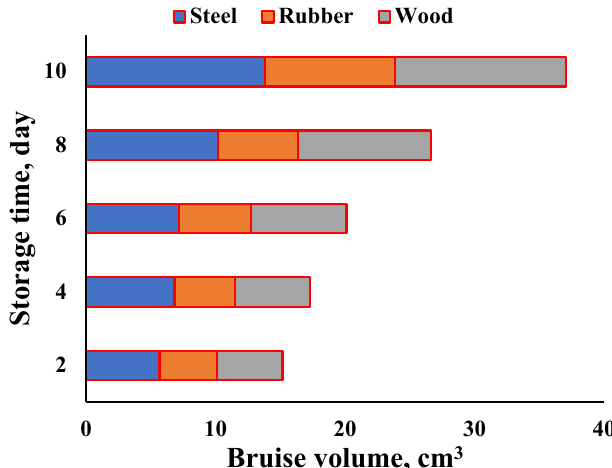
Figure 9. Impact energy of fruit due to different impact height at different impacted surfaces.